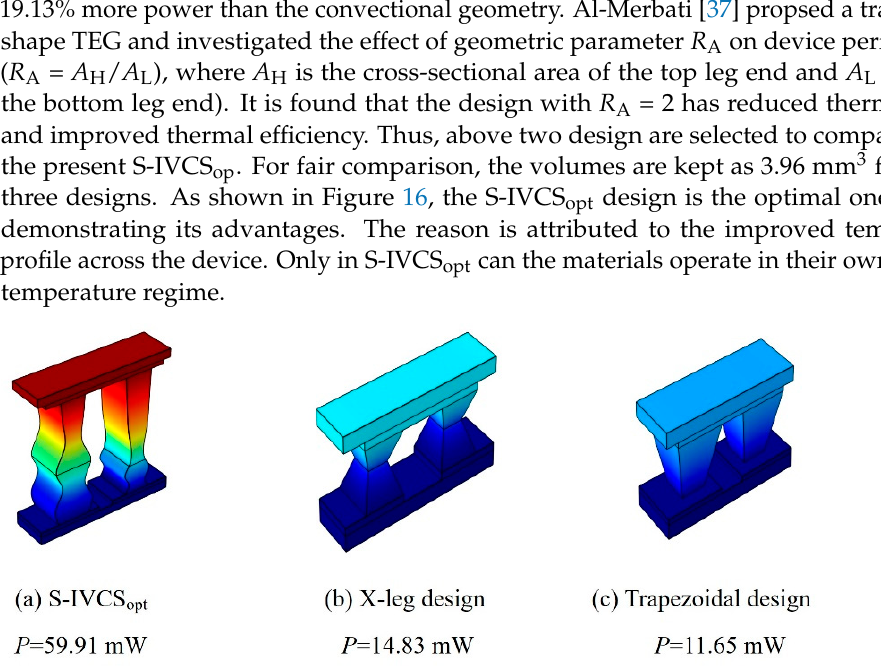
Table 5. The average figure of merit of the four designs.